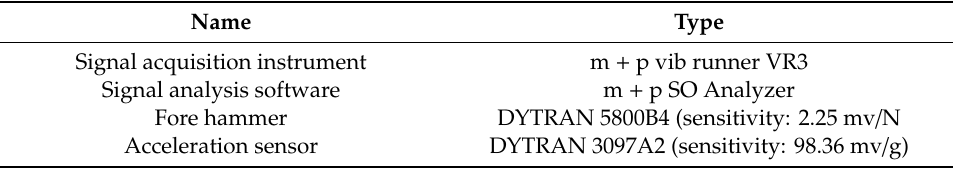
Figure 2. The modal test system. Table 1. Measurement devices and analysis software employed for modal test.